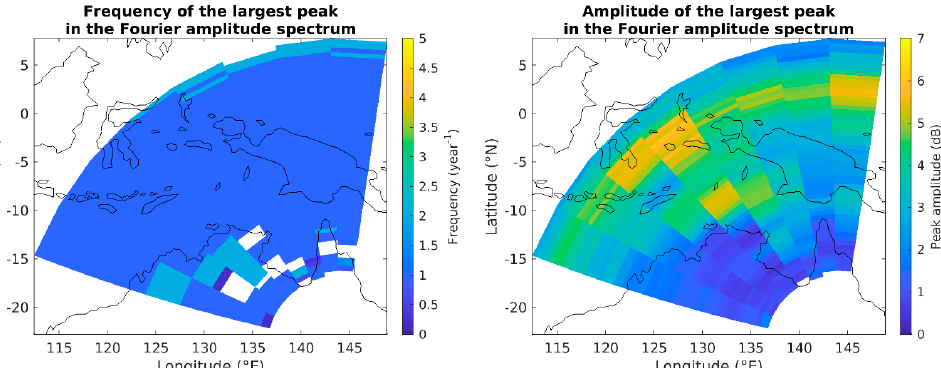
Figure 11. ( Left ): The frequency of the statistically significant (see text for details) primary peaks from the FFT for each LO range-azimuth cell. ( Right ): the amplitude of the largest peak from the FFT for each LO range-azimuth cell. Range-azimuth cells with greater than 50% missing data are excluded from the Fourier analysis.